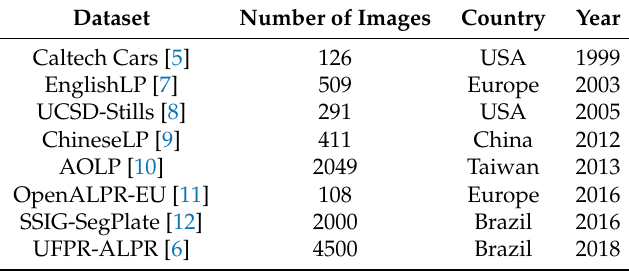
Table 1. Public license plate image